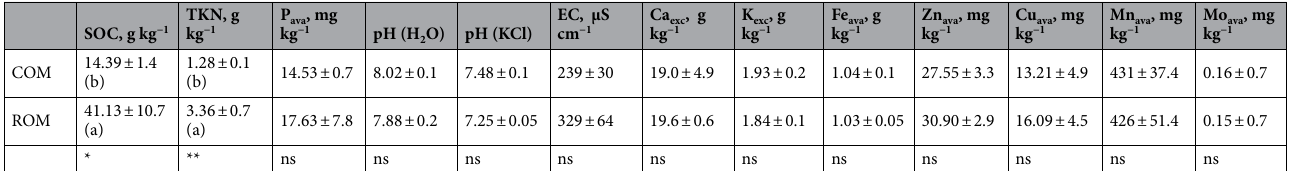
The main chemical characteristics of soils from Locone Lake are reported in Table 2. The reforested soil had significantly higher SOC (p = 0.012) and TKN (p = 0.006) content than pasture, while all other parameters did not show any significant differences. Table 3 reports the microbial and enzymatic properties of Lama Giulia soils. The cypress soil showed signifi-